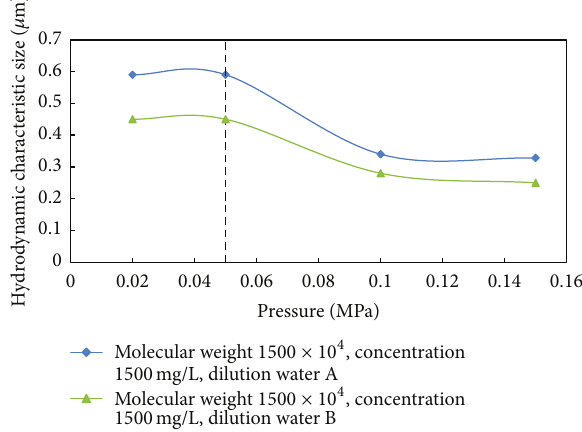
Figure 3: In order to both save time and achieve the biggest hydrodynamic characteristic size of polymer to study the matching relationship, a pressure 0.05 MPa was selected.